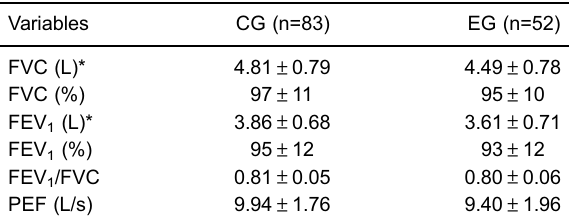
Table 2. Comparison of spirometry data among participants exposed and not exposed to occupational particulates.